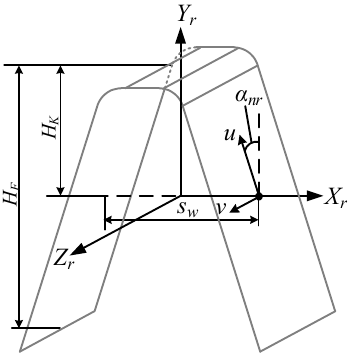
Figure 4. Profile of the equivalent rack.